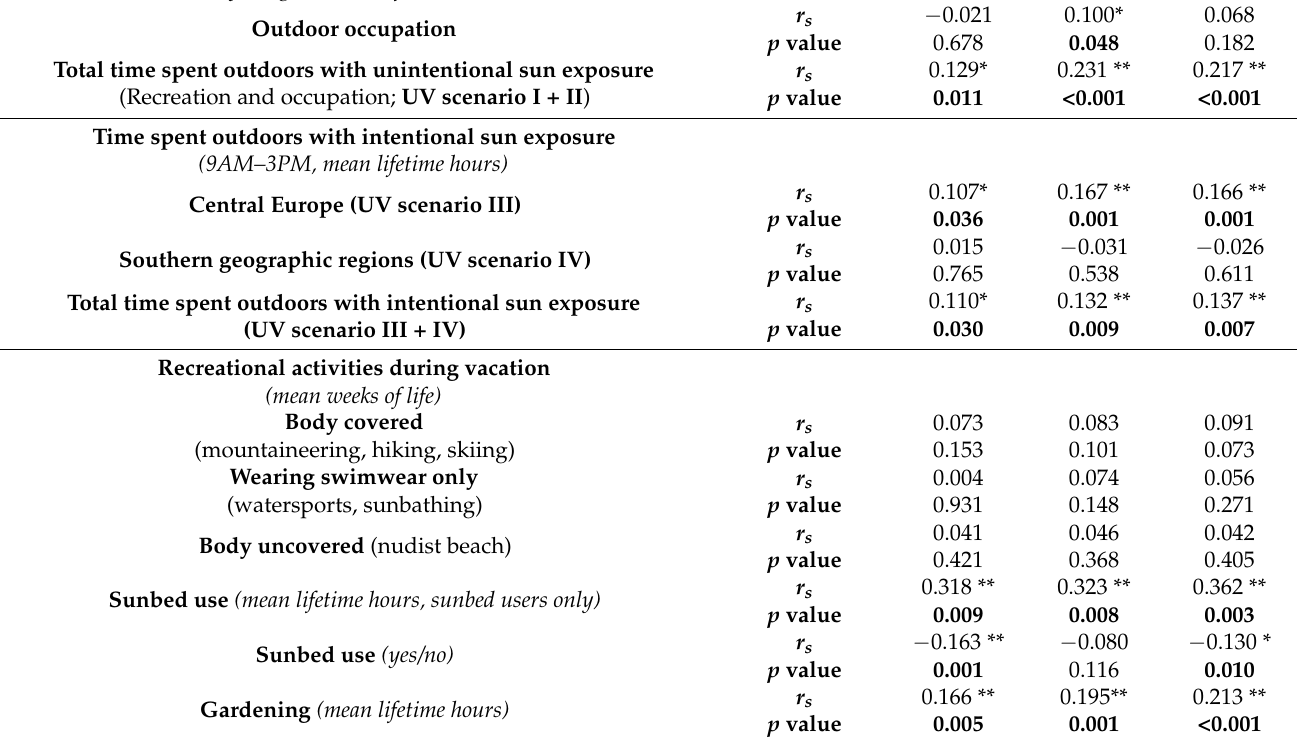
Skin Aging Score Intrinsic